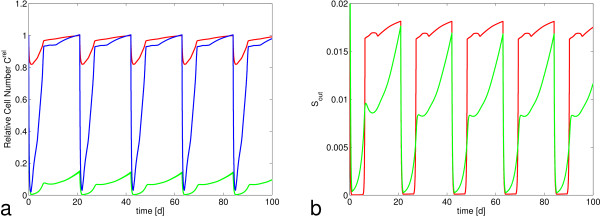
Comparison of stem cell dynamics in ODE and hybrid model. a) Stem cell number in the ODE model (green) is heavily reduced and does not recover within one cycle. In the hybrid model, total stem cell number (red) is only reduced to ~80%. Depletion of proliferative stem cells (blue) is similar to the ODE model, but regeneration is fast. b) Effluxes from the ODE SCC (green) and the hybrid model (red) almost vanish after drug administration, but increase simultaneously around day 7.